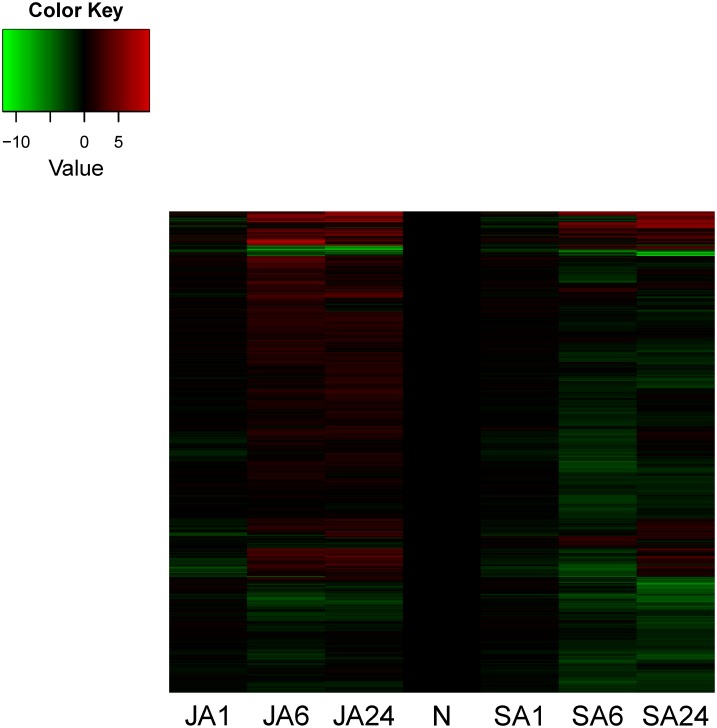
Heatmap of differentially epressed genes in Haematococcus pluvialis under SA and JA treatments.Each line represents an individual gene; the red and green lines represent the relative rise level and decline level of gene epression compared to the control level.